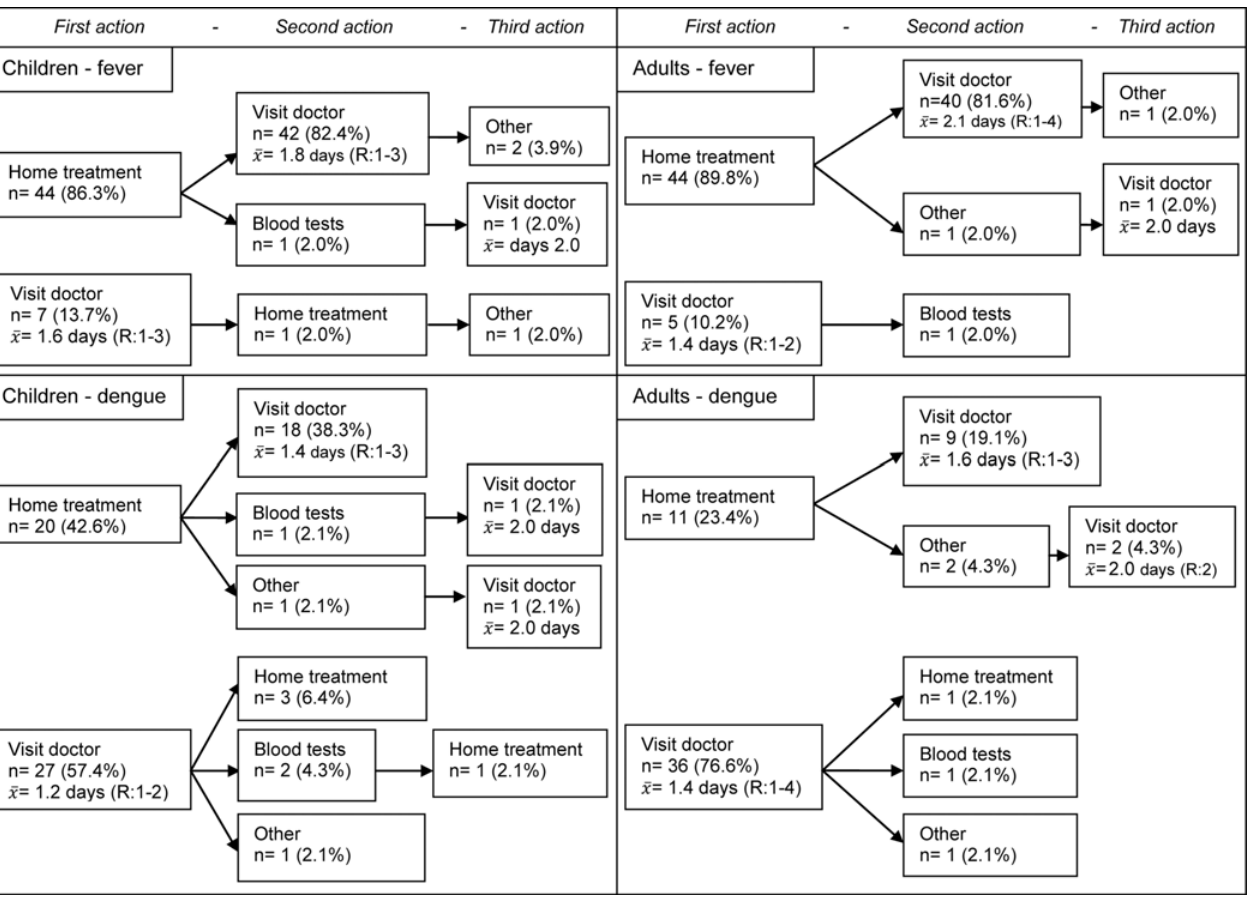
Fig 1. Intended health seeking behaviour pathways in the case of fever and suspected dengue. (cid:1) x = mean day when visiting a medical doctor; R = range of day chosen to visit a doctor (min – max). The upper-left and upper-right panel show the fi rst three steps intended to take in the case of fever by parents/guardians referring to their child and adults, respectively. The lower-left and lower-right panel show the fi rst three steps intended to take in the case of suspected dengue by parents/guardians referring to their child and adults, respectively. Percentages correspond with their contribution to the child sample (fever: n = 51 & dengue: n = 47) or the adult sample (fever: n = 49 & dengue: n = 47).